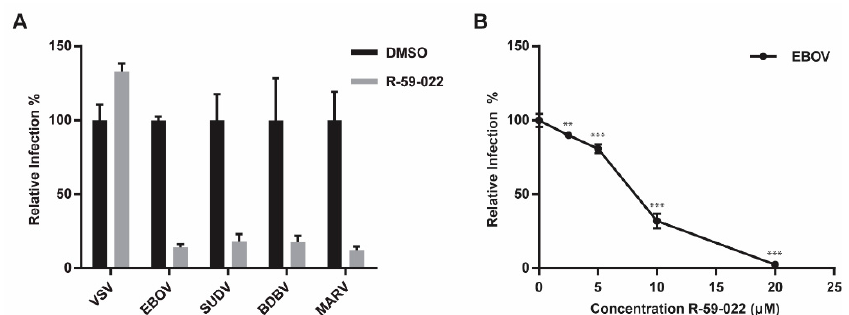
Figure 5. R-59-022 blocks entry of pathogenic filoviruses and growth of replication-competent EBOV ( A ) Infection of Vero cells with β lam VLPs harbouring the GPs of EBOV, SUDV, BDBV, MARV, or VSV G in the presence of 5 µ M R-59-022 or vehicle. Infection was measured using flow cytometry by determining the percentage of cells with cleaved CCF2. Data are expressed as percentages relative to vehicle-treated cells; ( B ) Infection of Vero cells with replication-competent EBOV expressing GFP at increasing concentrations of R-59-022 or vehicle. Infection was measured by GFP fluorescence 3 days post-infection and normalized to vehicle treated cells. Data is representative of 3 independent experiments. * p < 0.05, ** p < 0.01, *** p < 0.001.